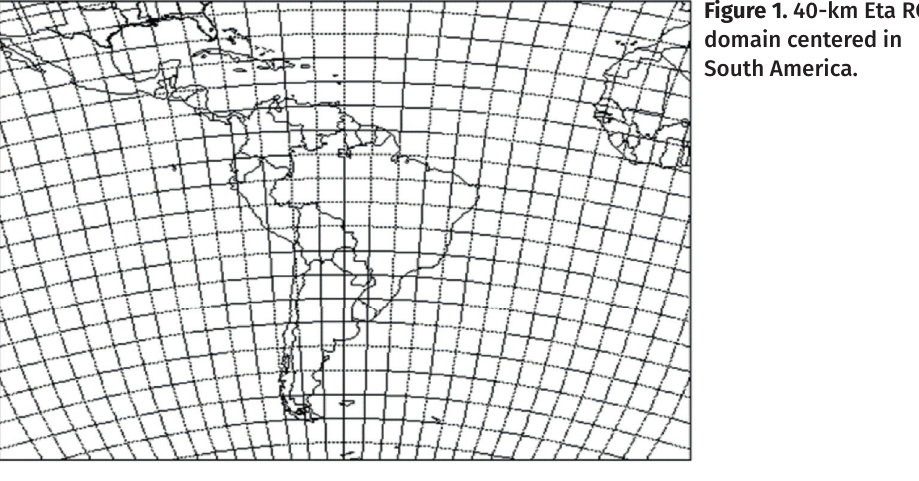
Figure 1. 40-km Eta RCM domain centered in South